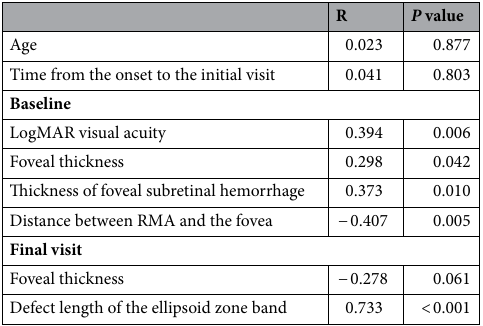
Table 3. Association between the final visual acuity and other clinical findings examined by Pearson’s product-moment correlation. LogMAR = logarithm of the minimal angle of resolution. Data are expressed as mean ± standard deviation unless otherwise indicated.